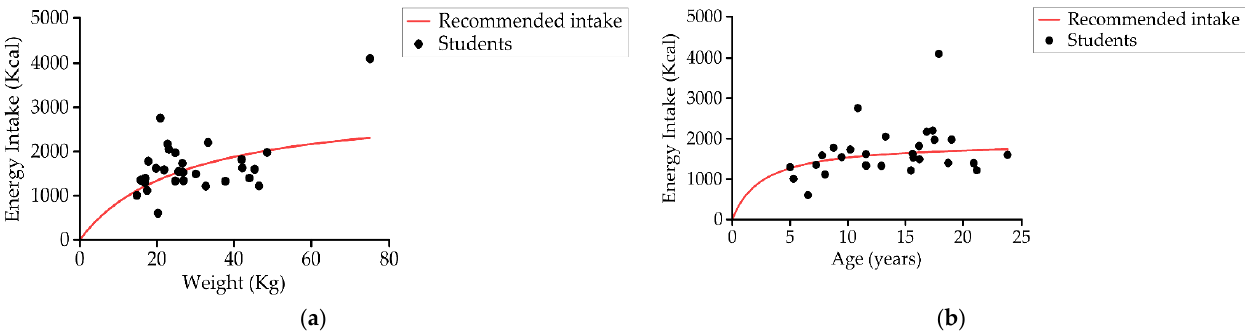
Figure 6. Relationship between students’ ( a ) energy intake (kcal/day) and weight, and ( b ) energy intake (kcal/day) and